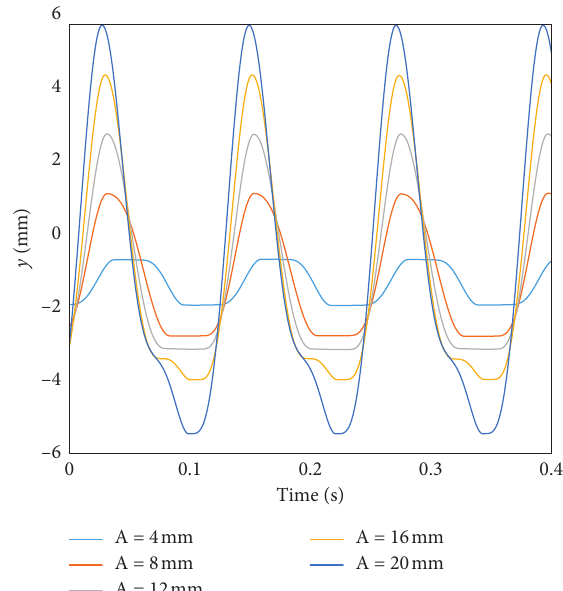
Figure 12: The influence of excitation amplitude on the response of the suspension system when excitation frequency � 7Hz.